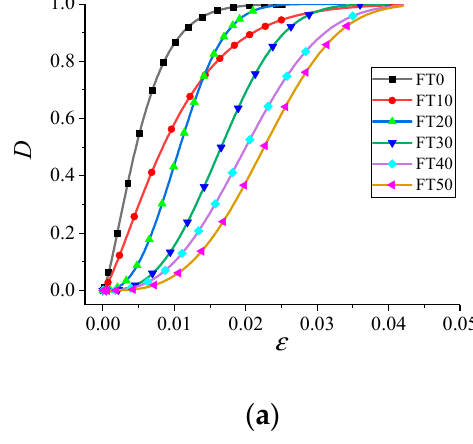
Table 2. Parameter inversion results of di ff erent constitutive models.